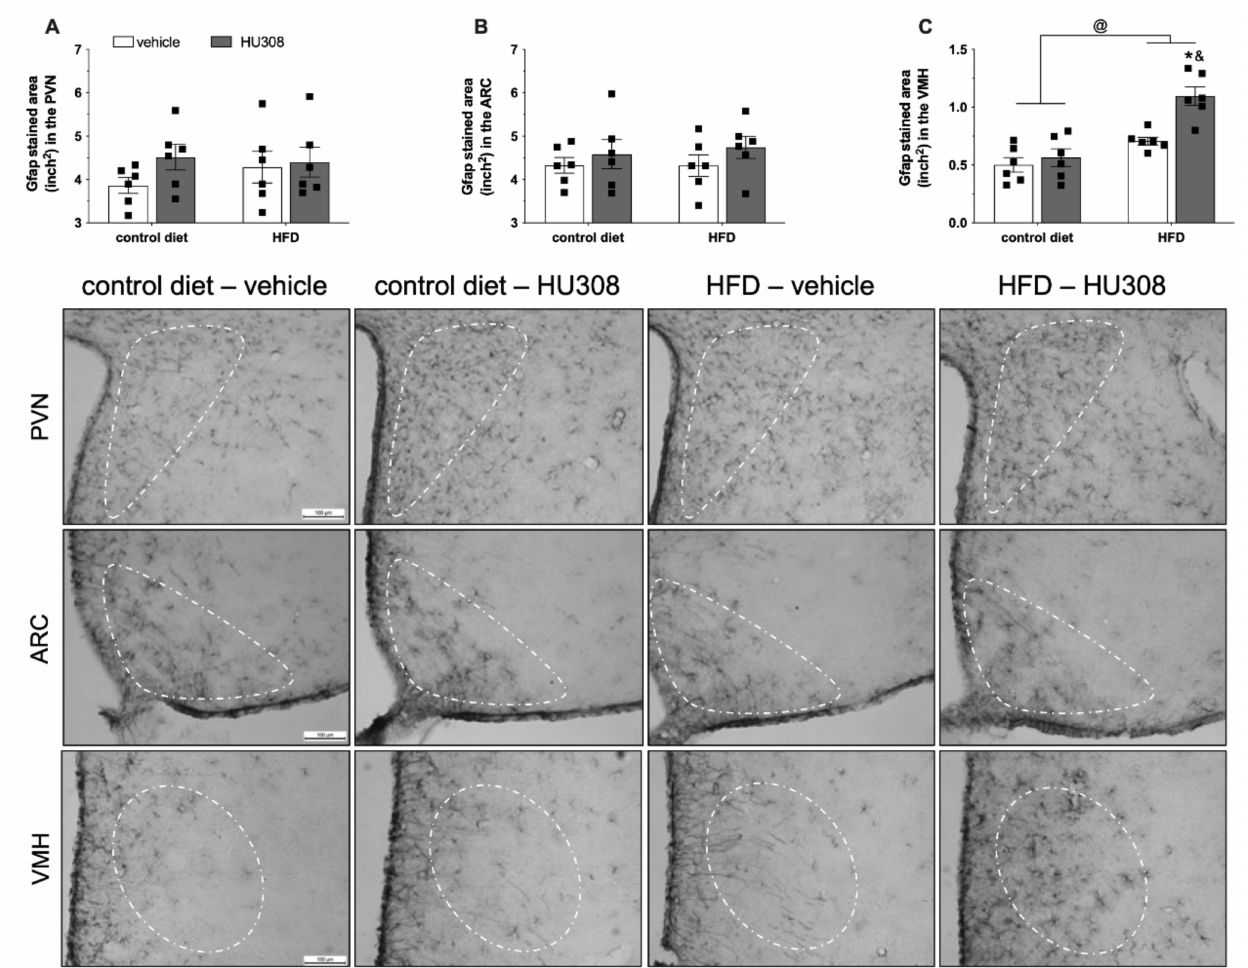
Figure 3. Effect of prolonged icv infusion of vehicle or HU308 for 2 weeks on the GFAP-stained area (inch2) in the paraventricular (PVN), arcuate (ARC) and ventromedial (VMH) nuclei in animals fed a control diet or high-fat diet (HFD). The GFAP-stained area (inch2) in the PVN ( A ), ARC ( B ) and VMH ( C ) nuclei in animals fed a control diet or HFD that received icv injection of vehicle or HU308. The data are expressed as the mean ± SEM; n = 6 per group. Data were analyzed by two-way ANOVA followed by Tukey’s post-hoc test. @ p < 0.001 (effect of diet), & p < 0.001 vs control diet+HU308 and, * p < 0.001 vs HFD+vehicle. Bottom panel: Representative photomicrographs of GFAP immunostaining in the PVN (superior panel), ARC (central panel) and VMH (inferior panel) of control diet-fed or HFD-fed animals treated with vehicle or